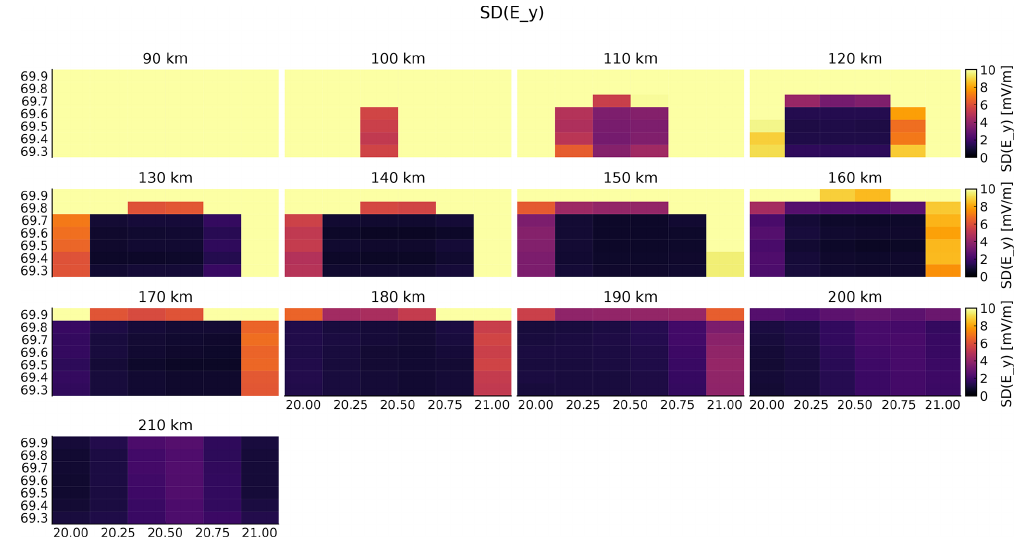
Figure 7. Uncertainty in electric field in local magnetic north